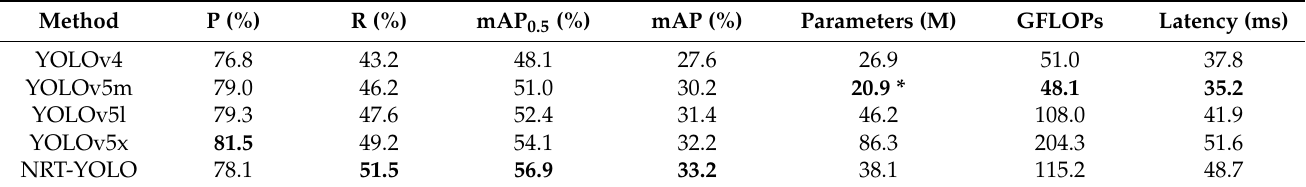
Table 1. Comparison results between NRT-YOLO and other YOLO methods.